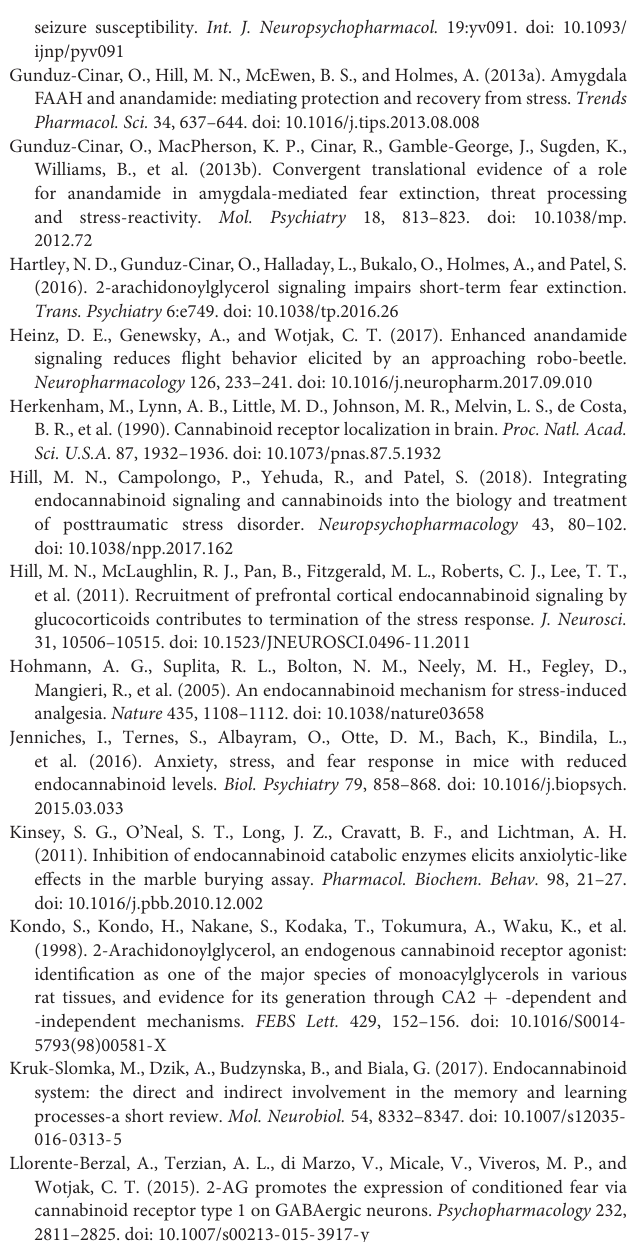
with an additional injection of THC 30 min prior to extinction training (THC 0.6 mg kg − 1 ) (Far right panel) % freezing during auditory cue during CS recall ( n = 14 DO34 + THC-treated male mice, n = 13 DO34 + vehicle = treated male mice, n = 14 vehicle + vehicle-treated male mice). F - and P -values and η 2 obtained by repeated measures two-way ANOVA representing effect of DAGL + THC treatment, DO34 + vehicle treatment, and vehicle only treated animals, prior to fear extinction training. A separate ANOVA was conducted to compare DO34 + THC and DO34 + vehicle-treated animals, and is shown. Colored dots corresponding to treatment legend delineates which treatments are represented in each analysis. All values are given as mean ± SEM. (C) In a separate experiment, there was no significant difference in total freezing behavior between two doses of THC (THC 0.3 and 0.6 mg kg − 1 ) on extinction days 2 and 3. Significance values obtained by Student’s t -test of total freezing behavior during the entire